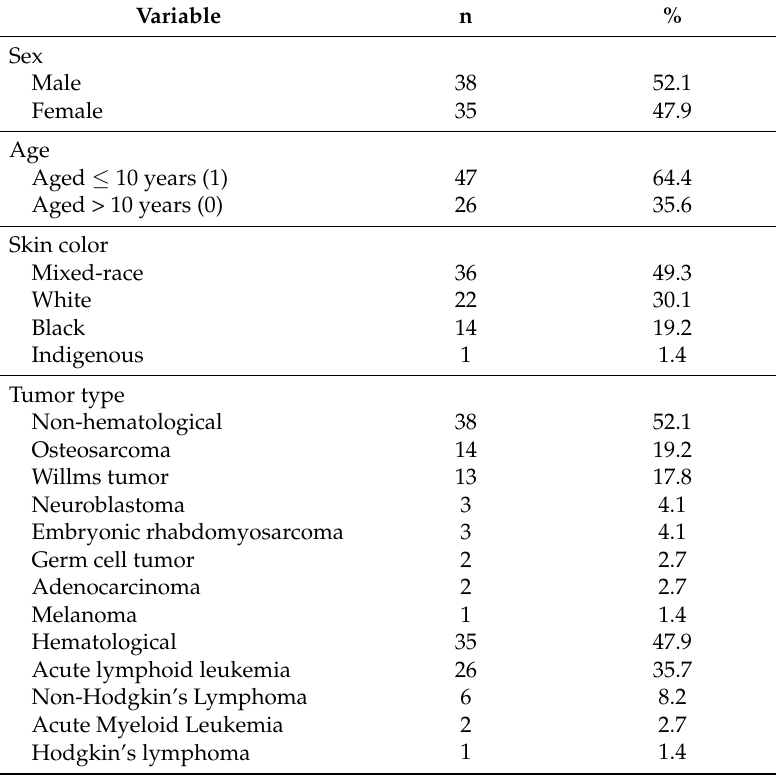
Table 1. Descriptive analysis of oncopediatric patients with severe oral mucositis in Napole ã o Laureano Hospital. Jo ã o Pessoa, Para í ba State, Brazil